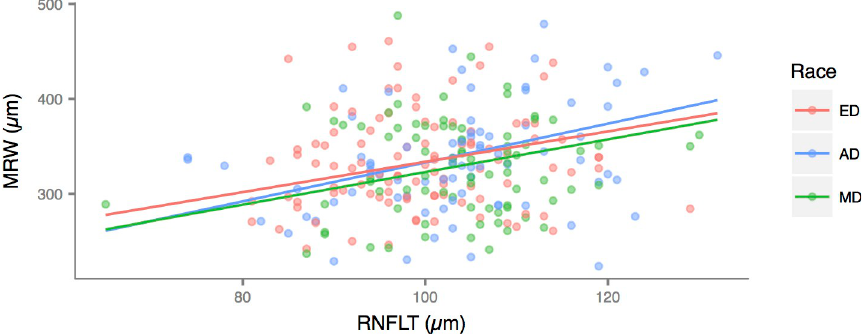
Fig 5. Scatterplot showing the relationship between global minimum rim width (MRW) and peripapillary retinal nerve fiber layer thickness (RNFLT) by racial group. The relationships did not differ among the three groups. ED: European Descent; AD: African Descent; MD: Mixed Descent.